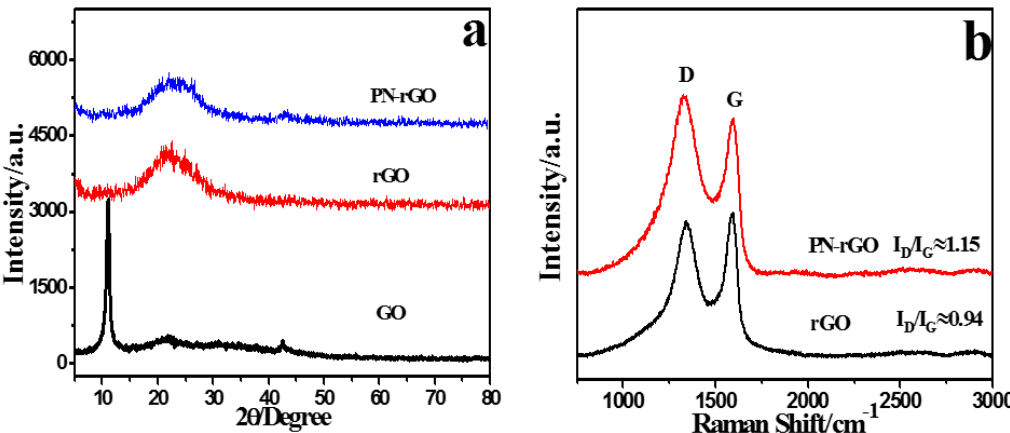
Figure 2. X-ray diffraction (XRD) patterns of GO, rGO and PN-rGO ( a ), Raman spectra of rGO and PN-rGO ( b